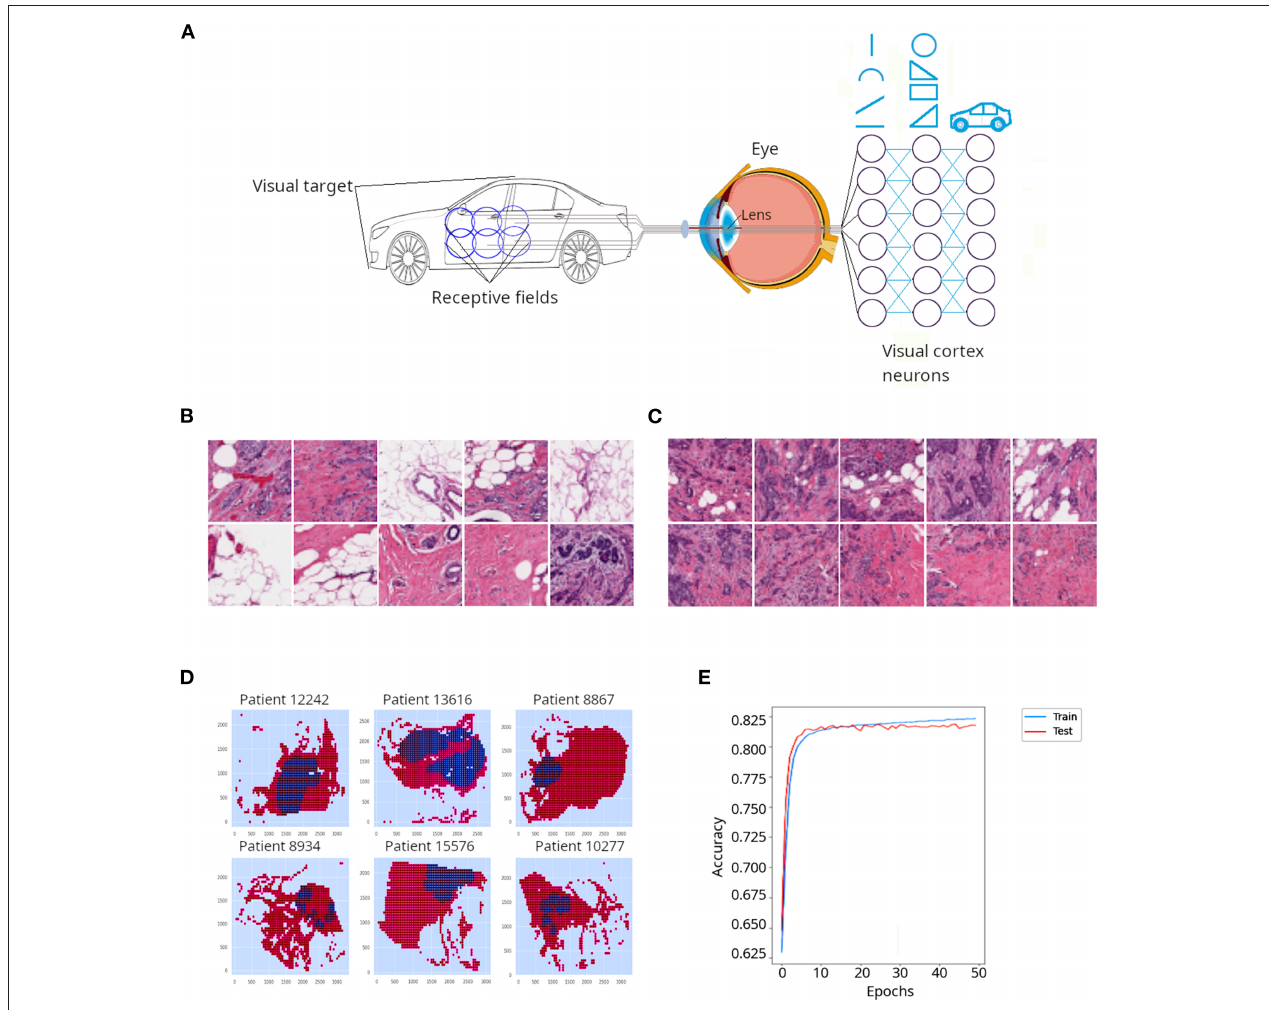
FIGURE 4 | Application of a convolutional neural network (CNN) to classify cancer tissue. (A) CNNs are emulations of sets of neurons that detect individual overlapping visual sections called receptive fields. Such neurons detect simple features of the object, such as lines and arcs. Deeper neuronal layers detect more complex shapes derived from the initial elements and progressively the whole object is resolved. (B) Representative patches from the invasive ductal carcinoma (IDC) tissue sections described in Cruz-Roa et al. (46) and classified as non-cancerous tissue by a pathologist. (C) Representative patches from the invasive ductal carcinoma (IDC) tissue sections classified as cancerous tissue by a pathologist. In (B,C) , darker regions correspond to nuclei stained with hematoxylin, which appear denser in (C) probably due to increased cell proliferation in cancerous tissues. (D) Digital reconstruction of tissue sections from individual patches in six different patients. Red regions represent non-cancerous tissue, while blue regions represent cancerous tissue. (E) Accuracy for training and test data sets obtained when a CNN was applied to the IDC